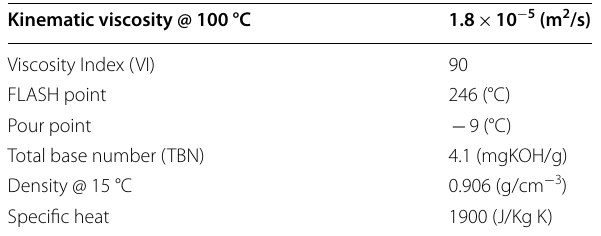
Table 4 Specifications of the base fluid